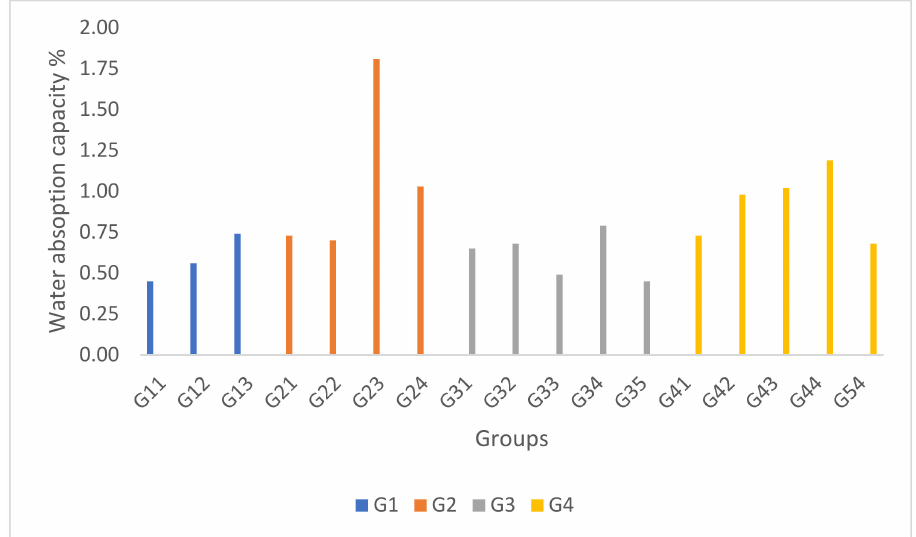
Figure 4. The water absorption capacity of the hybrid GFRP